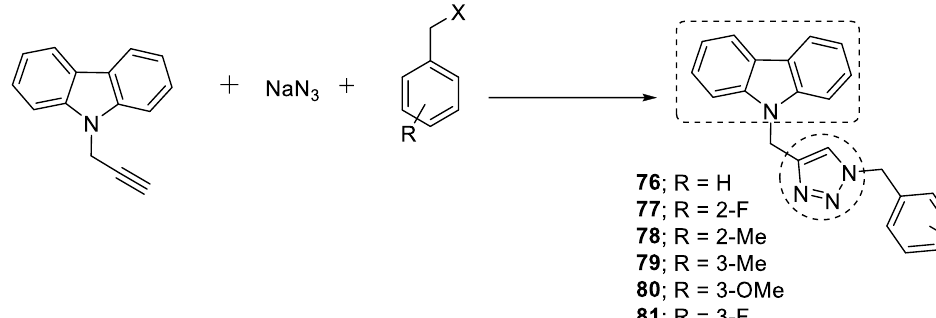
Figure 27. Chemical structures of carbazole-1,2,3-triazole hybrids.